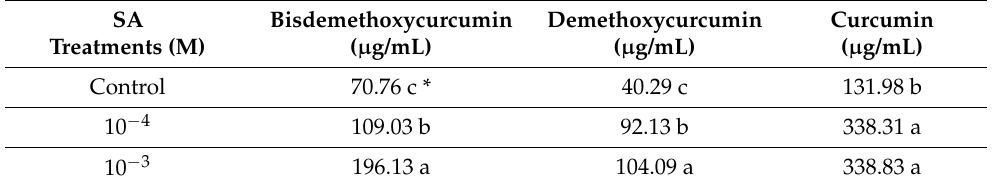
Table 10. Effects of SA treatment on bisdemethoxycurcumin, demethoxycurcumin, and curcumin (ug/mL) accumulation in C. longa in the second